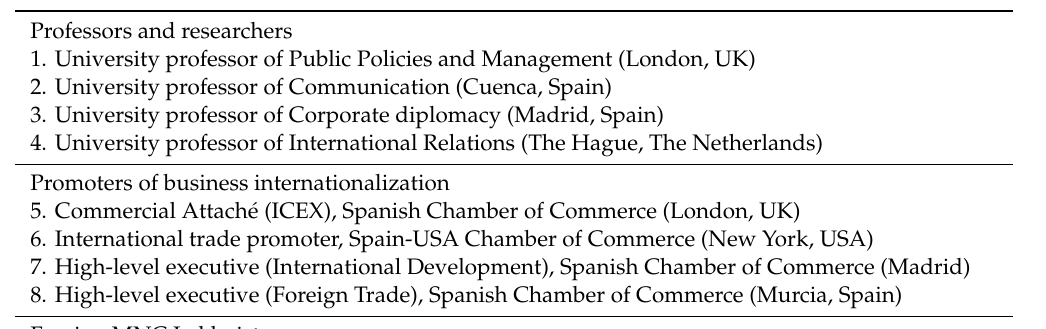
Table 2. Focus Group 1